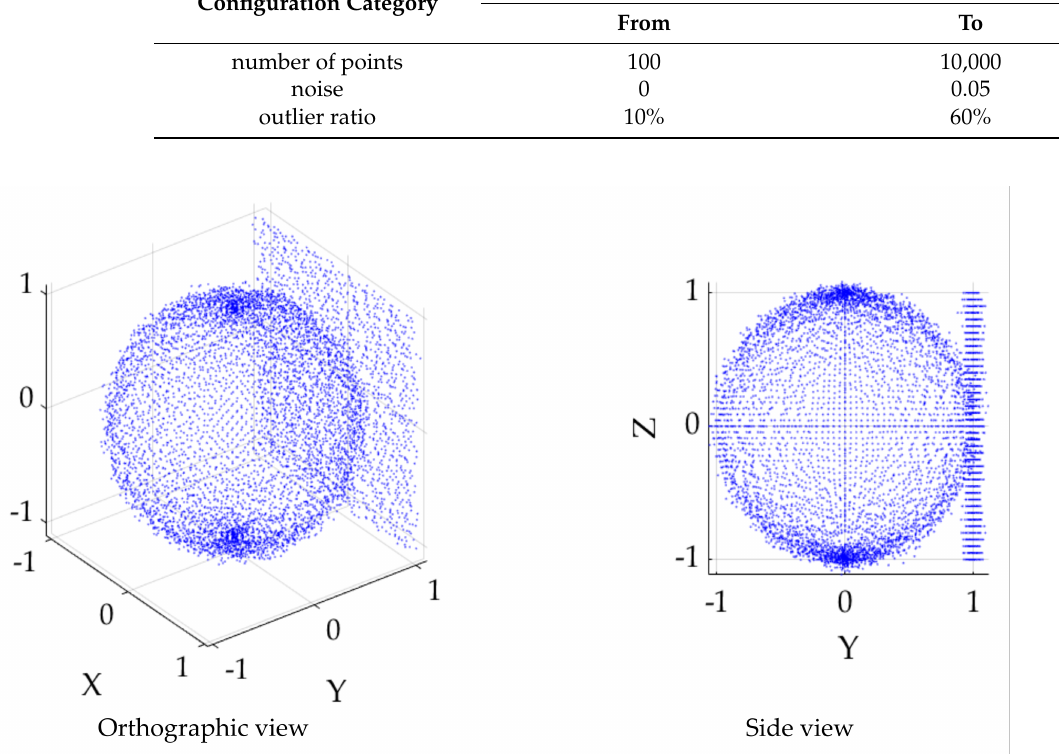
Figure 3. Simulated 3D point cloud of a unit sphere with the tangential plane in orthographic ( left ) and side ( right )